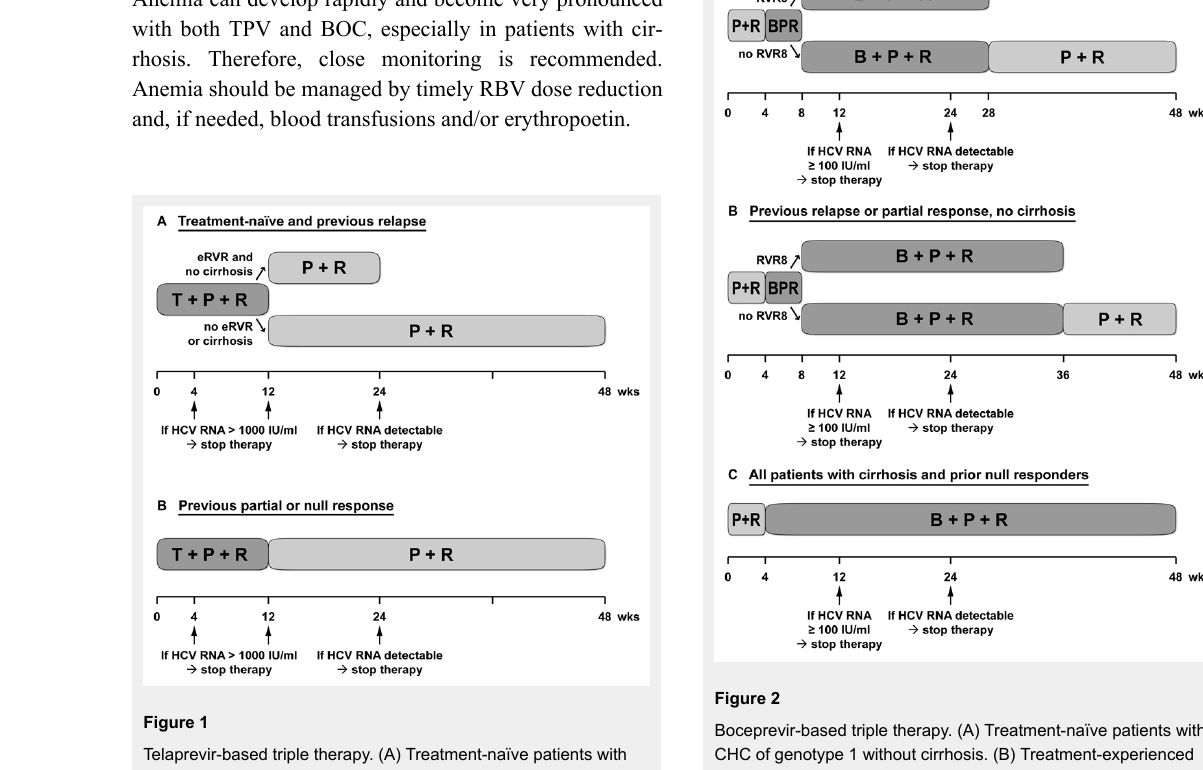
Telaprevir-based triple therapy. (A) Treatment-naïve patients with CHC genotype 1 and treatment-experienced patients with previous relapse. (B) Treatment-experienced patients with CHC genotype 1 and previous partial or null response. eRVR, extended rapid virological response (see table 1 for definitions of virological response patterns); P, pegylated interferon-α; R, ribavirin; T, telaprevir; wks, weeks.